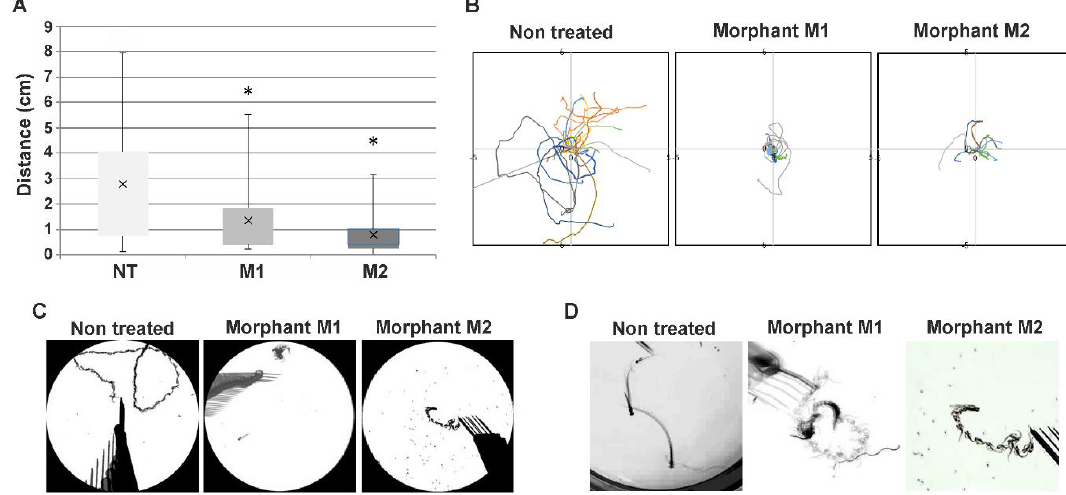
. Figure 5. Altered swimming behavior in zebrafish embryos with decreased hspb8 level. ( A ) Box plot represents distribution of swimming distances in the touch-evoked response (TER) assay, measured in cm; NT: non-treated embryos ( n = 86); M1 ( n = 28) and M2 ( n = 75) morphants: embryos after hspb8 knockdown using, respectively, morpholino oligonucleotides (MO) 1 and 2. Statistical analyses were performed using ANOVA followed by the Games–Howell post hoc test, p < 0.05; each experiment was repeated at least three times. Asterisks (*) indicate significantly di ff erent groups. Error bars show the standard deviation. ( B ) The colored lines demonstrate video recorded tracks of swim trajectories of individual embryos ( n = 10) stimulated to move by a physical touch to the head. ( C ) Representative traces of individual swimming episodes of investigated embryos showing the typical (in the case of